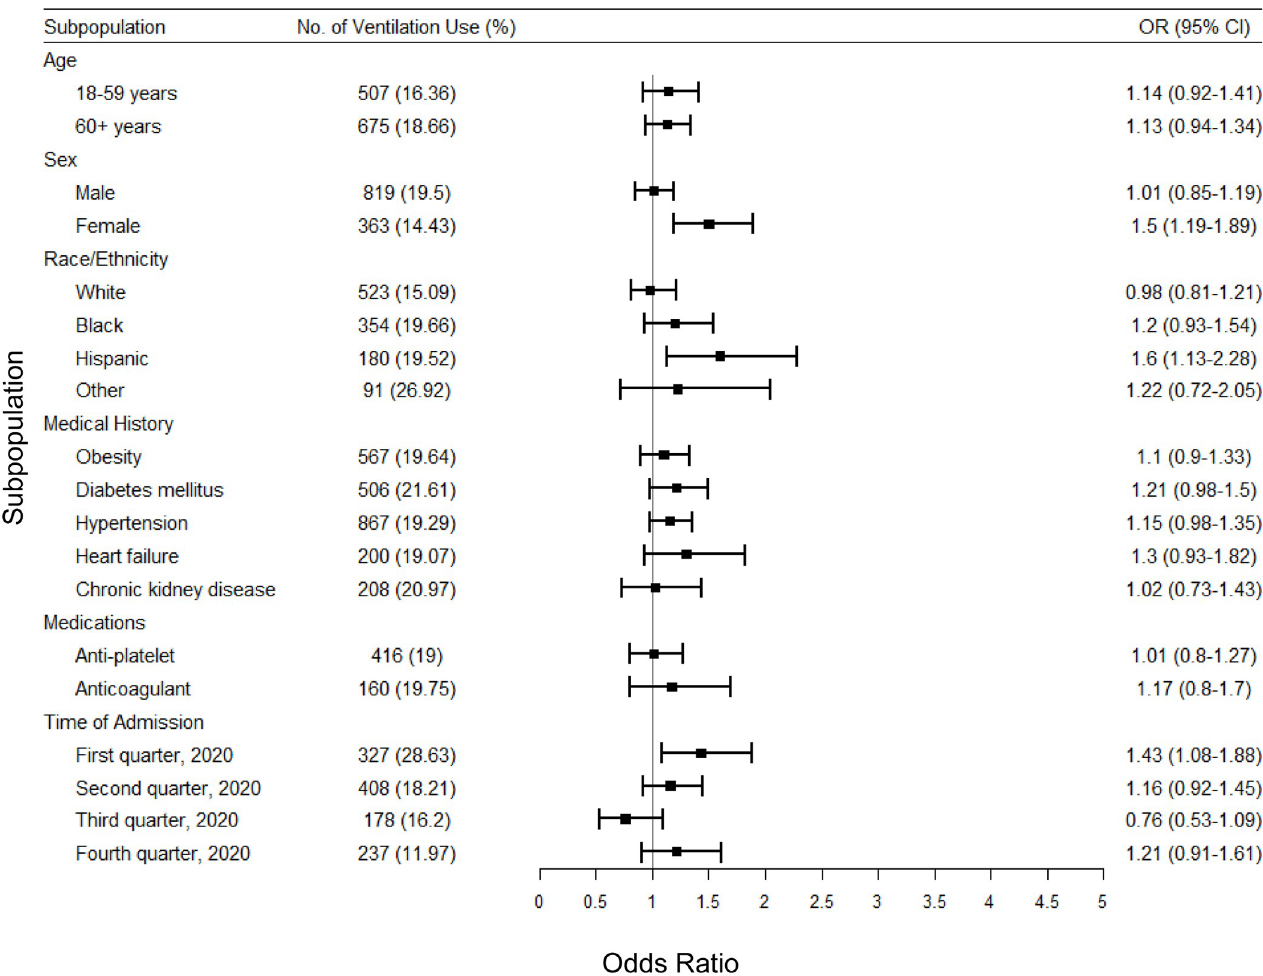
Fig 2. Multivariate analysis of associations between smoking and mechanical ventilator use in subpopulations among the propensity-matched study population of the AHA COVID-19 CVD Registry from December 2020 to March 2021. Mechanical ventilation use is defined as the hospitalization, intubated, or placed on mechanical ventilation. Obesity is defined as BMI > = 30 kg/m 2 . OR, Odds ratio; CI, Confidence